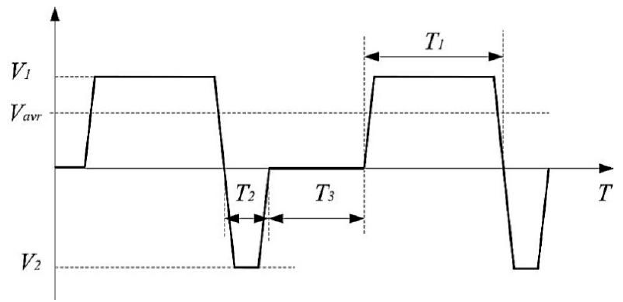
Figure 2. Wave form of wire feeding speed (feed withdrawal mode).